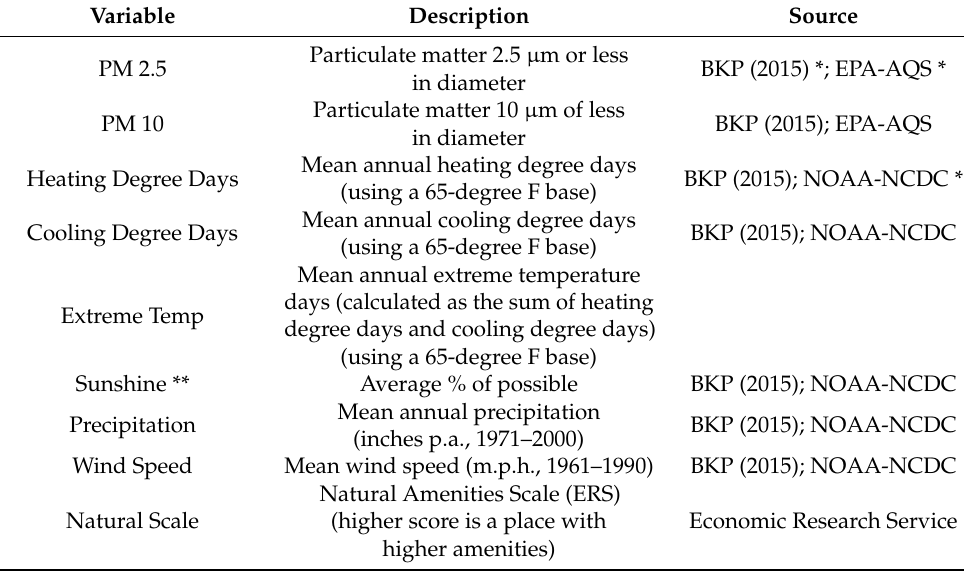
Table A2. Climate, geographic, and environmental variables.